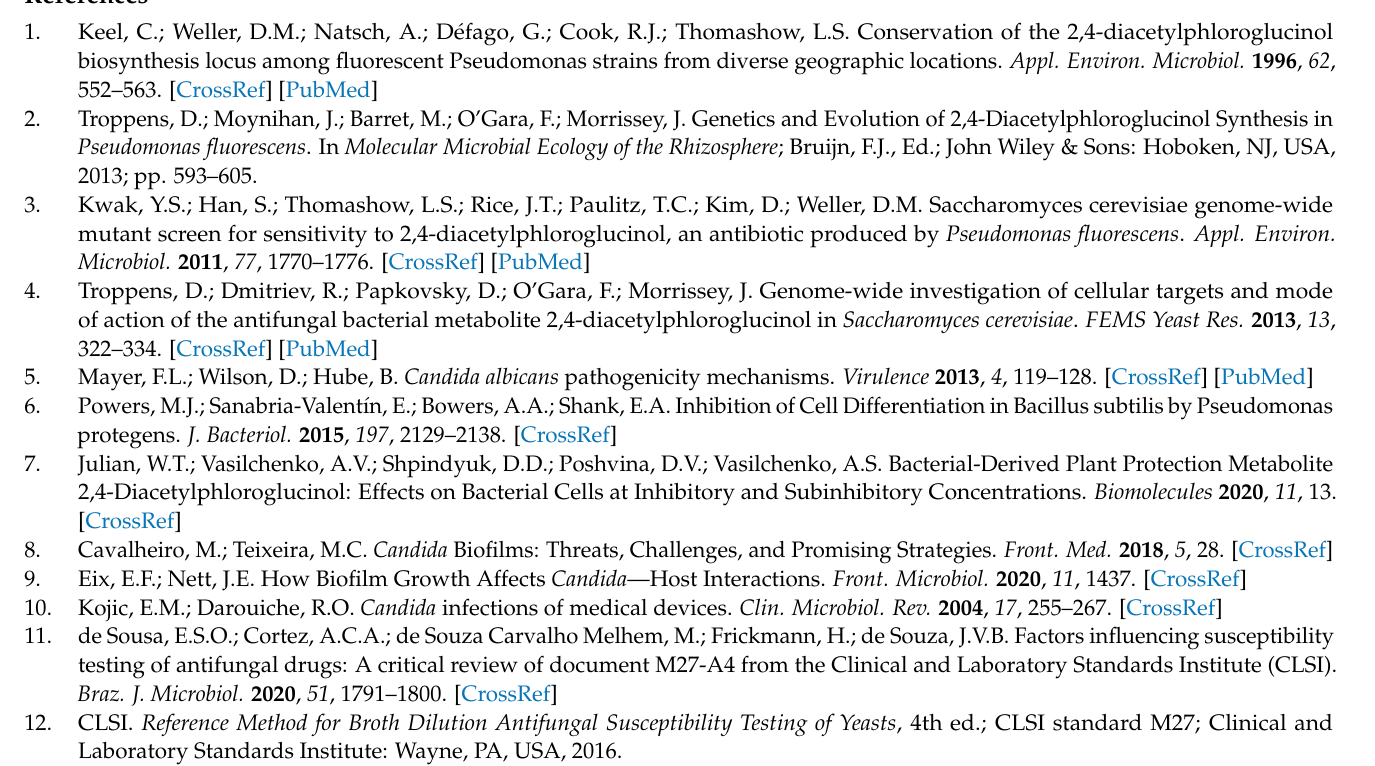
Figure S3. Inhibition of the C. albicans ATCC 10231 filamentation; Table S1: The ability of Candida albicans cells to form germ tube in the presence of 2,4-DAPG and exogenous tyrosol; Table S2. Primers used in the RT-qPCR